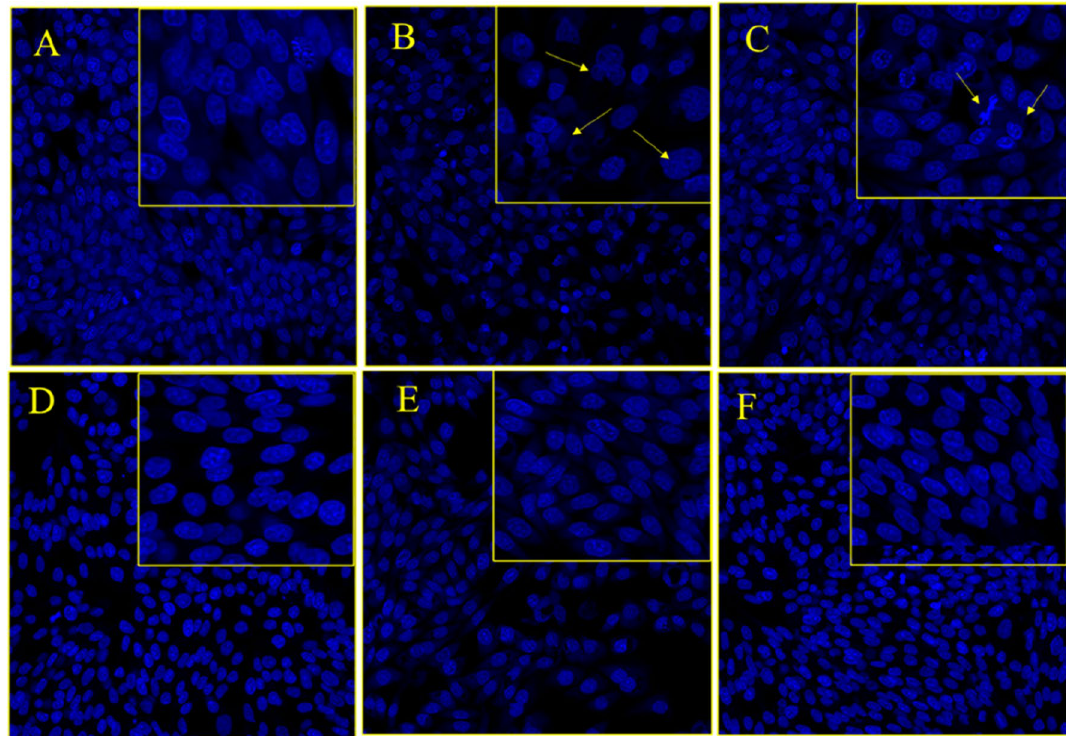
Figure 9. The impact of MNPs and MENCs treatment on HCT-116 cells stained with DAPI after 48-h treatment. ( A , D ) are the control cell, ( B ) (CoNiFe), ( C ) (CoMnFe), ( E ) (CoNiFe@BTO), and ( F ) (CoMnFe@ BTO). Arrows show the apoptosis